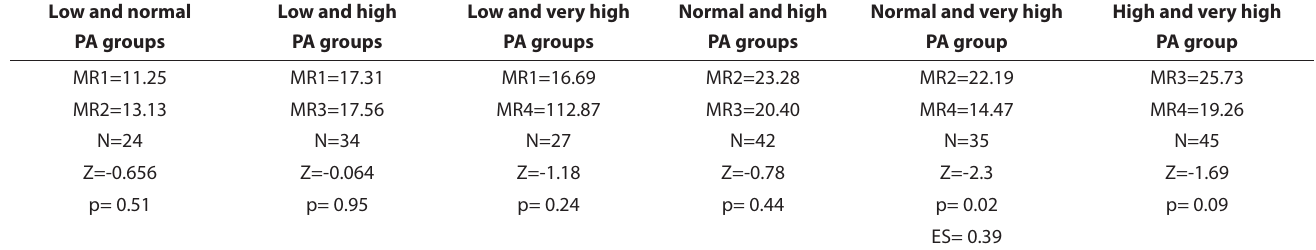
TABLE 3 Mann-Whitney U test for objectively measured PA groups and AP Low and